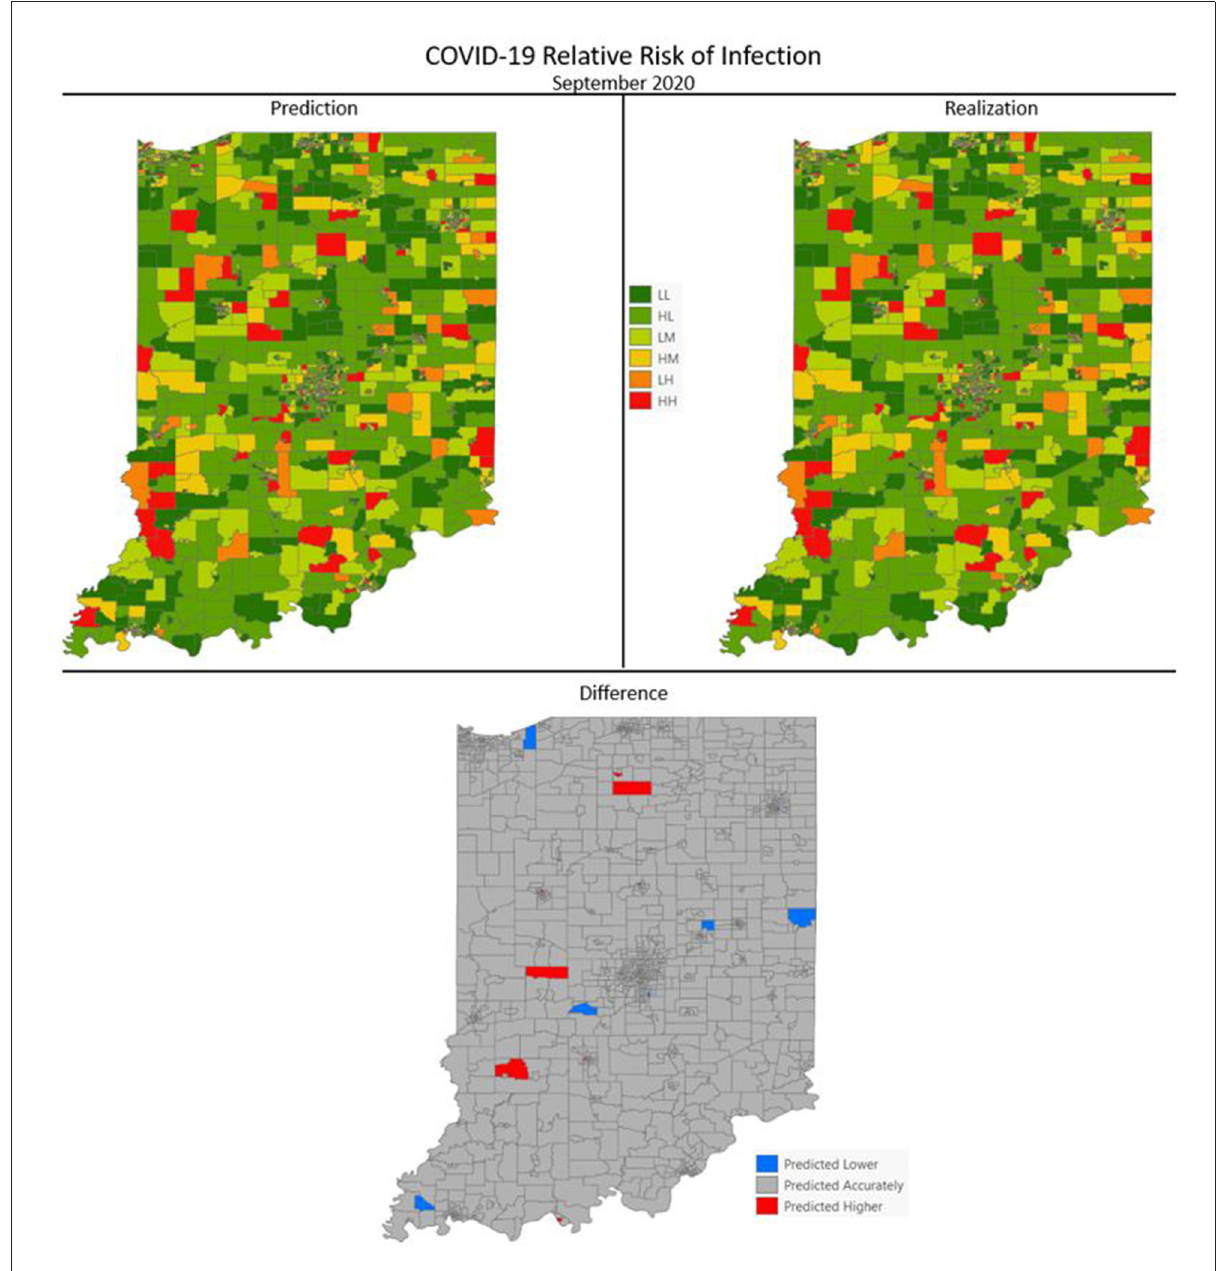
FIGURE10 COVID-19 categorical relative risk of infection prediction and realization for September